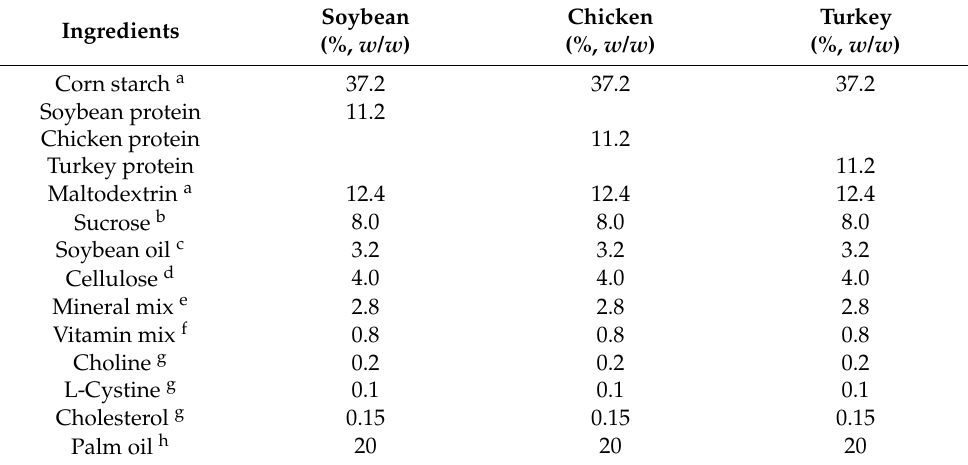
Table 1. Composition of experimental